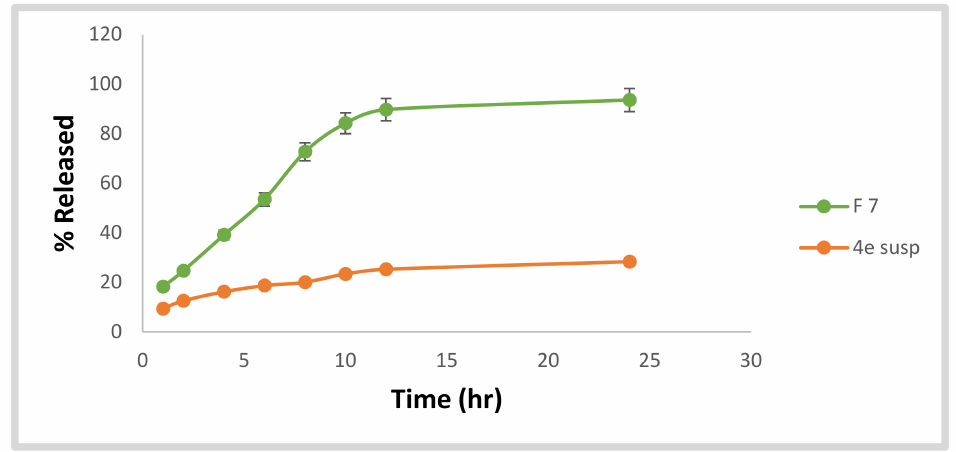
Figure 15. Percentage of 4e released ± S.D. from the optimized PEGylated bilosome formula (F7) compared to that of 4e